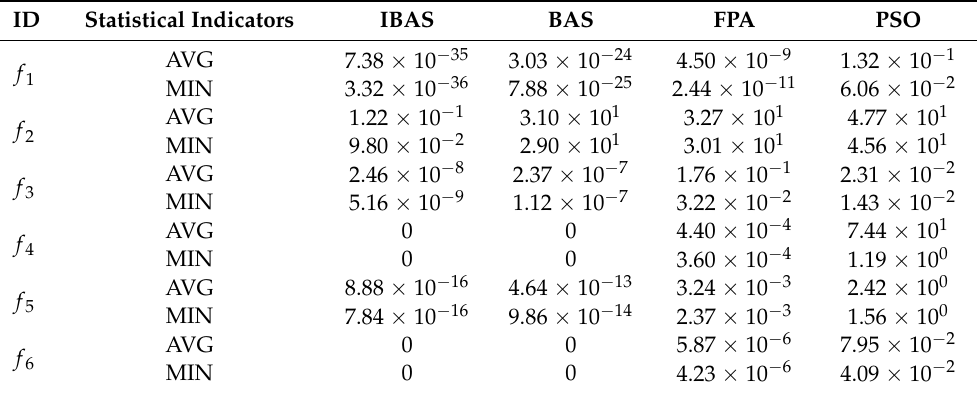
Table 3. Algorithm test